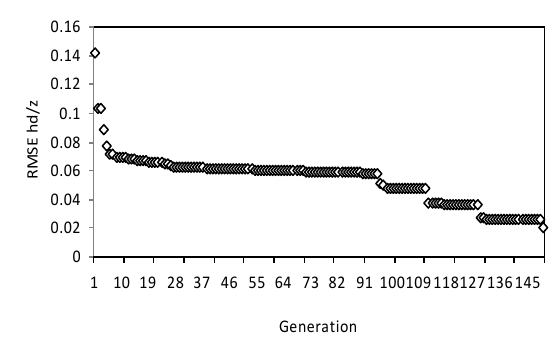
Figure 13. Root mean square error versus generation of h d /z .